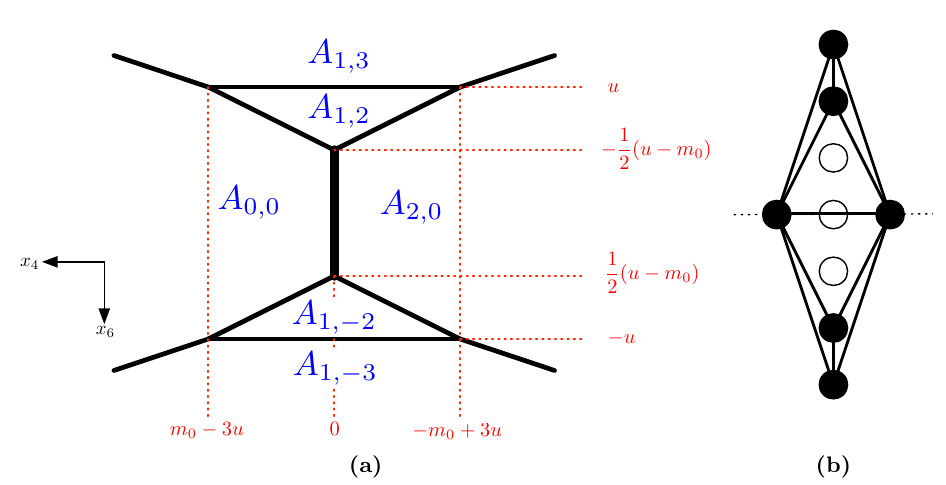
Table 5. The regions where each A ( m ) of the